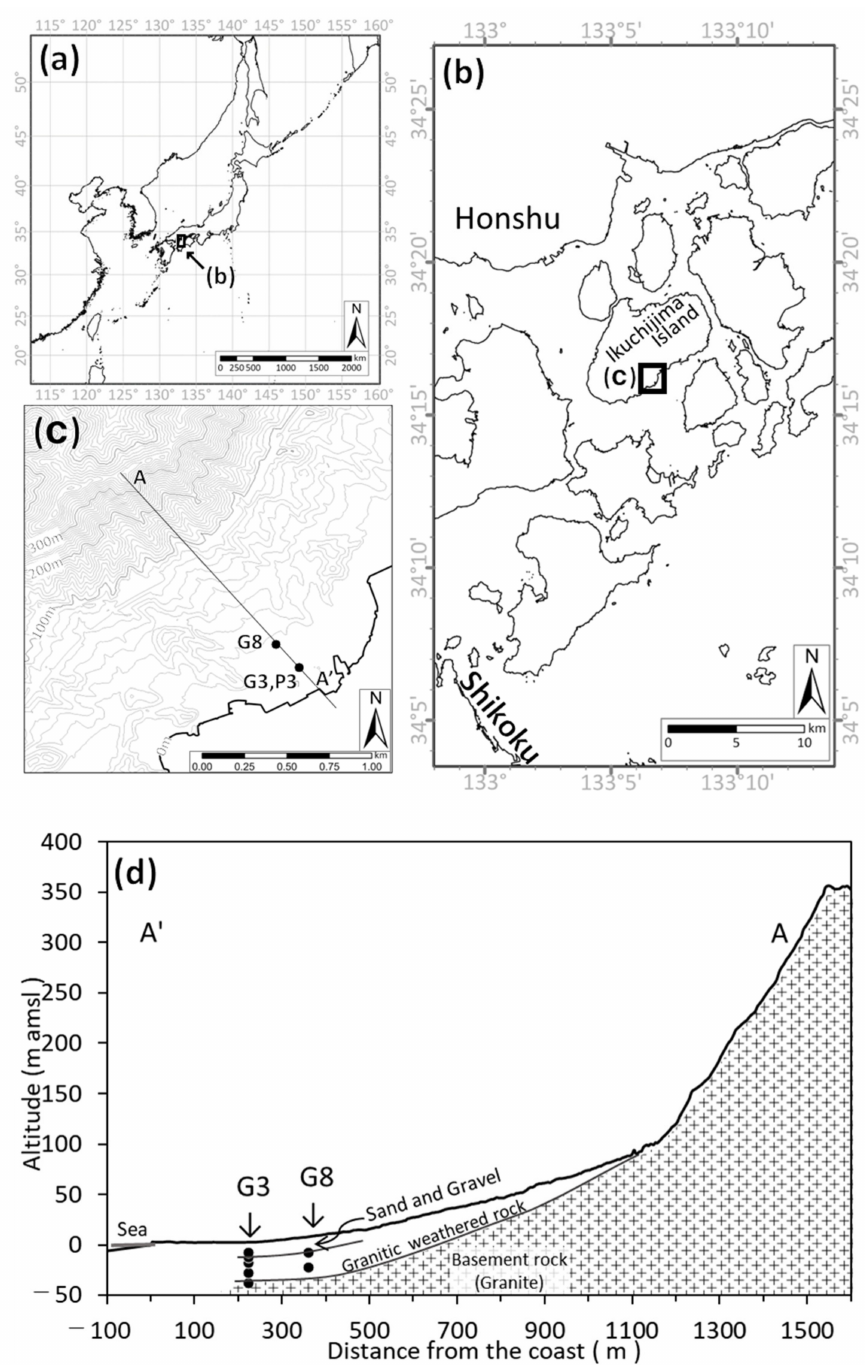
Figure 1. Observation site. ( a ) Map of Japan. ( b ) Map of Ikuchijima Island and its surrounding areas. ( c ) Contour map of the watershed area with the locations of G3 and G8 across A-A’. ( d ) Cross-section of